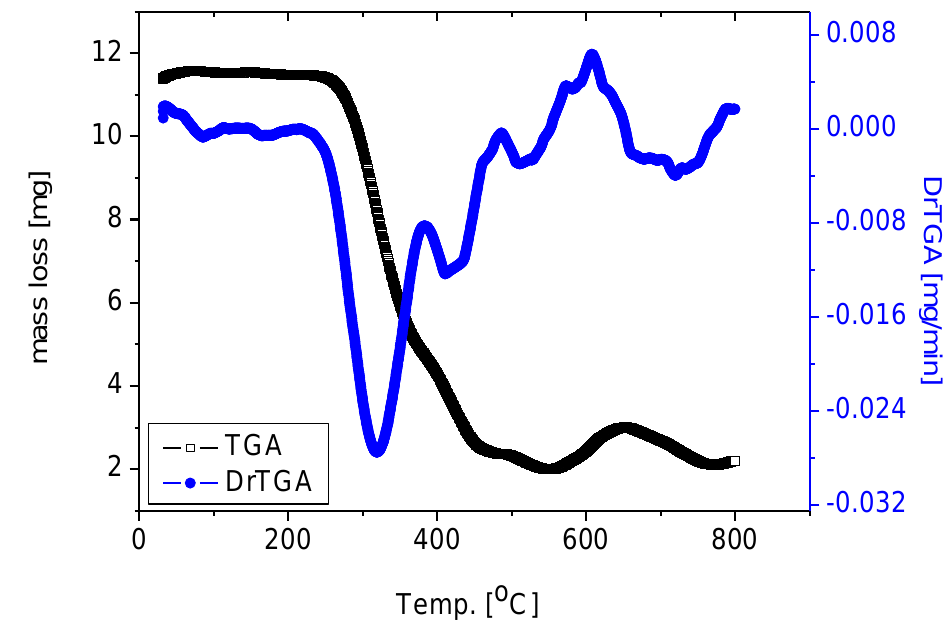
Figure 3. TGA and DrTGA curves of Ru III /Q complex.